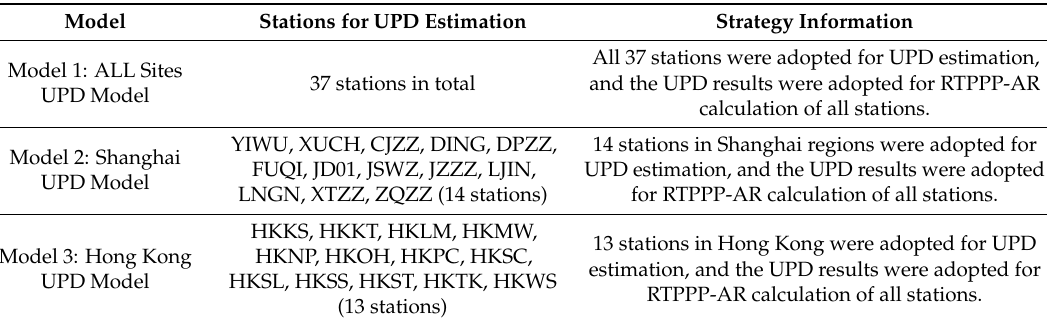
Table 3. Calculation Strategy Information Sheet for Different UPD Estimation Models. Model Stations for UPD Estimation Strategy Information